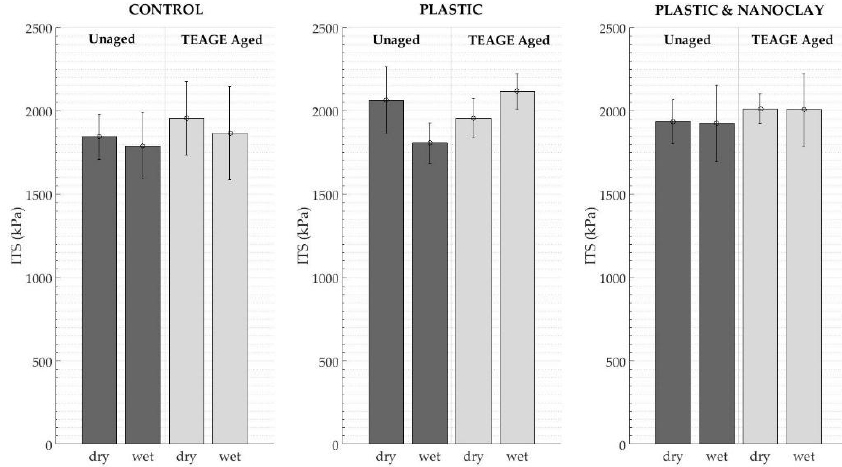
Figure 6. Indirect tensile strength (ITS) results.